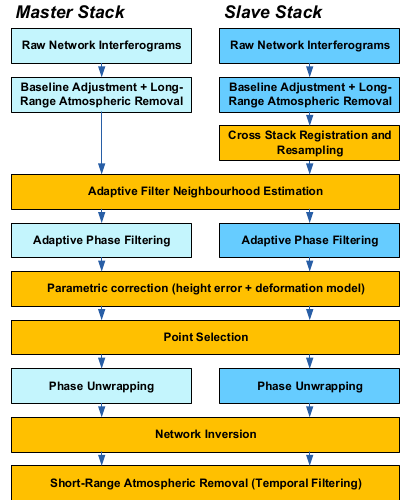
Figure 1. Multi-Track HDS-InSAR processing flowchart. Joint processing steps are shown in orange.